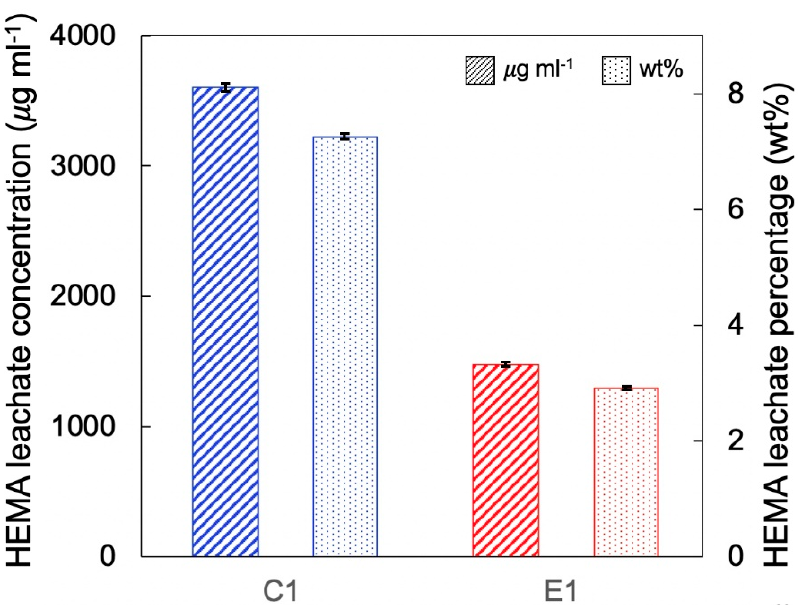
Figure 5. Cumulative concentration and weight percentage of HEMA leachate that was released from C1 and E1 samples after 4 days of aqueous aging.